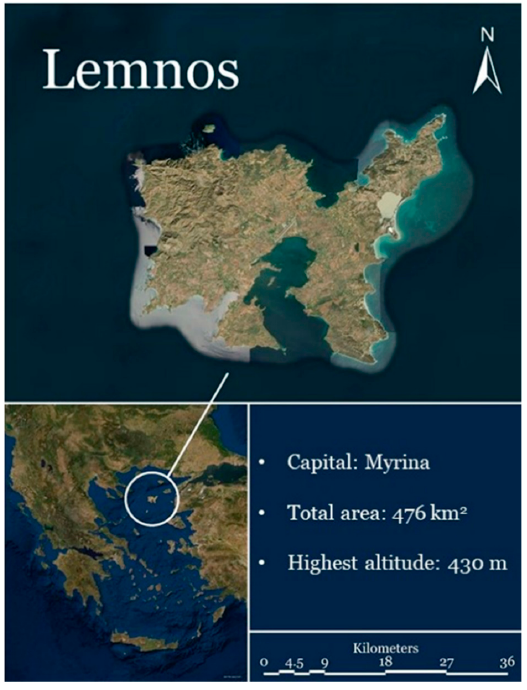
Figure 1. Map of Lemnos (source: ArcGIS